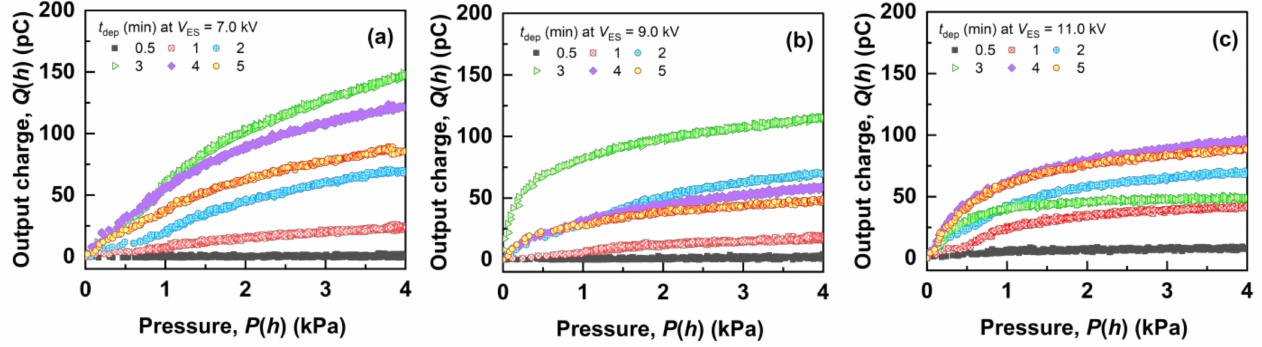
Figure 3. Q ( h ) with P ( h ) of the fiber mats produced with different t dep and V ES . ( a ) 7.0, ( b ) 9.0, and ( c ) 11.0